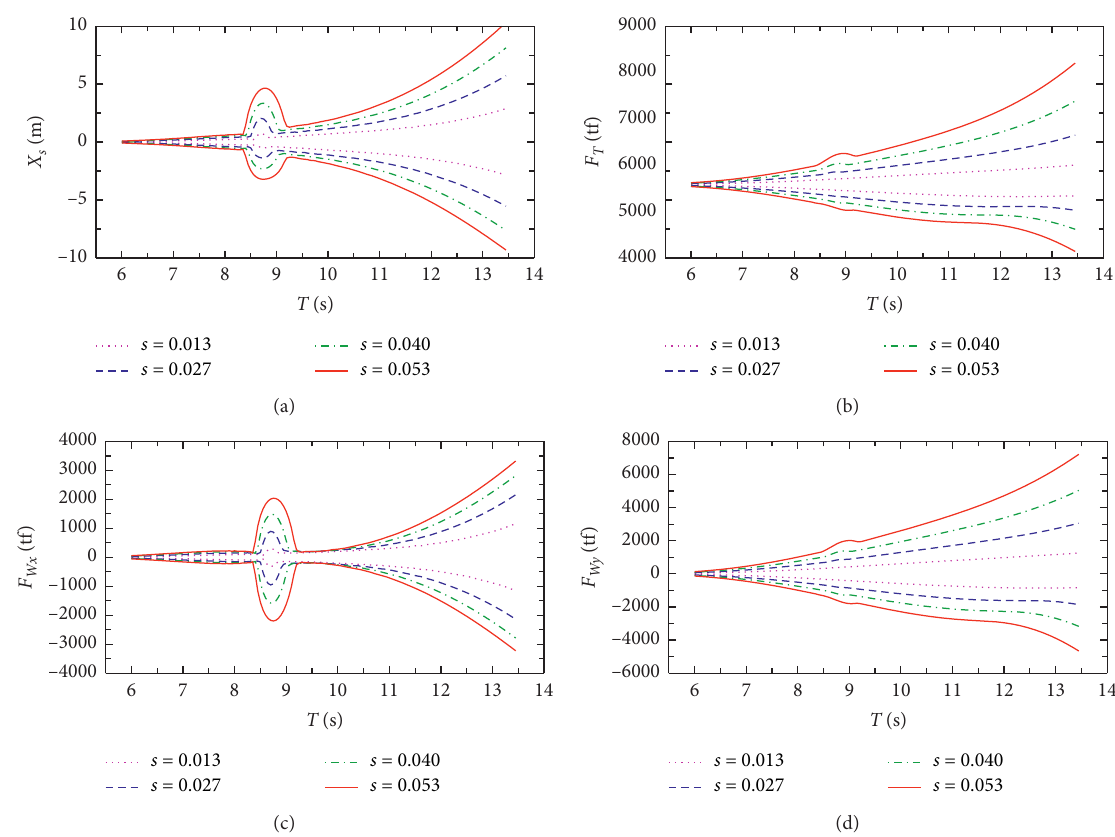
Figure 10: Relevant physical quantities are changed by various wave periods T with different wave steepness (s): (a) the horizontal displacement of the tube X s , (b) the mooring cable tension F T , (c) the horizontal wave forces F Wx , and (d) the vertical wave forces F Wy (BWR � 2.6; d �